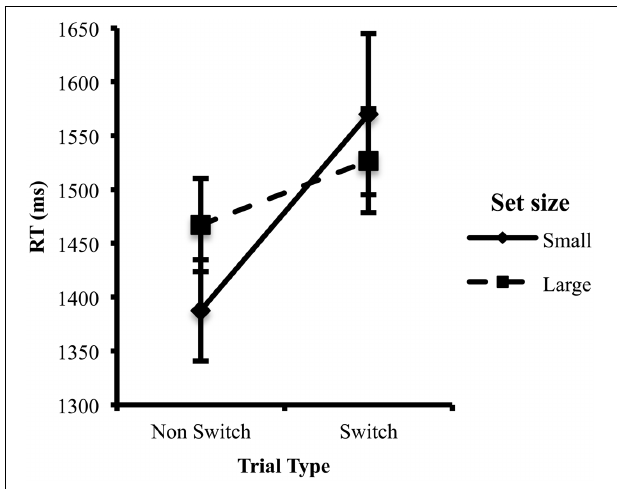
FIGURE 2 | Mean RT in the switch and non-switch trials as a function of the set size. Error bars indicate the standard error of the mean.